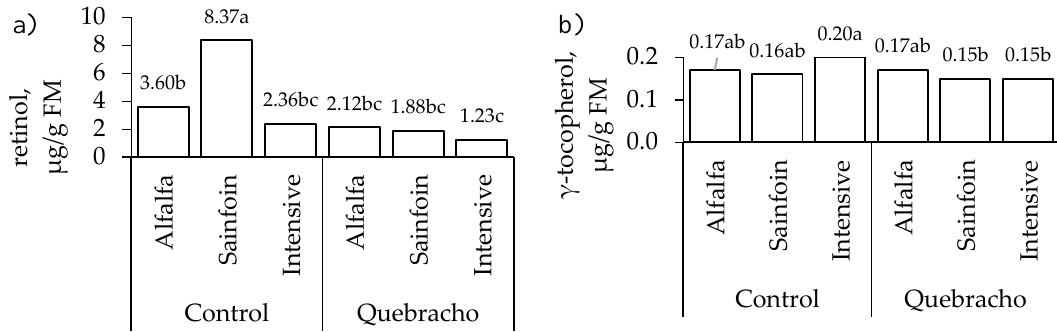
Figure 3. Effect of the maternal feeding and the inclusion of quebracho in the concentrate on the content of retinol in the liver ( a ) and γ-tocopherol in the muscle ( b ). Within a parameter, means with a different letter differ at p < 0.05.